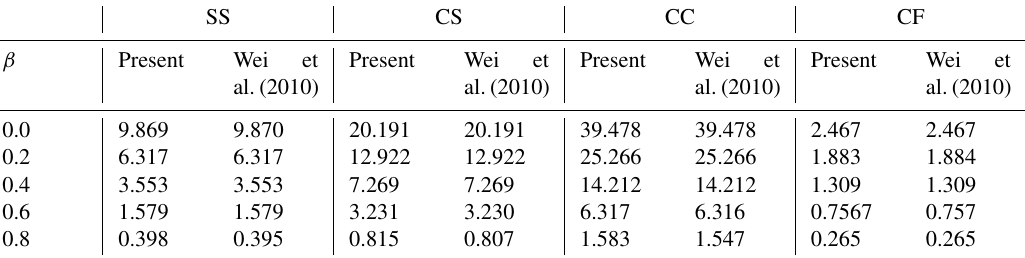
Table 1. Comparison of buckling loads p (concentrated load only) with existing results for four boundary conditions with EI ( X ) = EI 0 (1 − βX ) 4 and µ = 0 (local